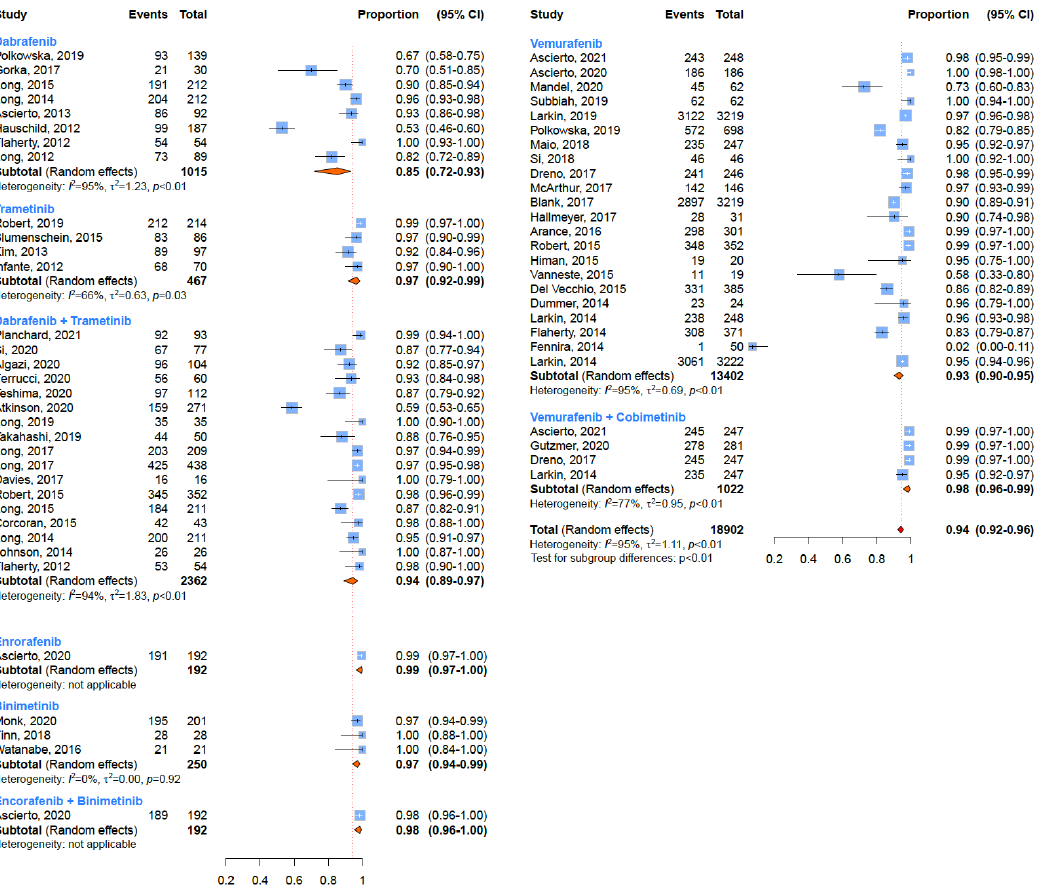
Figure 2. Overall incidences of all-grade adverse events according to treatment regimen.